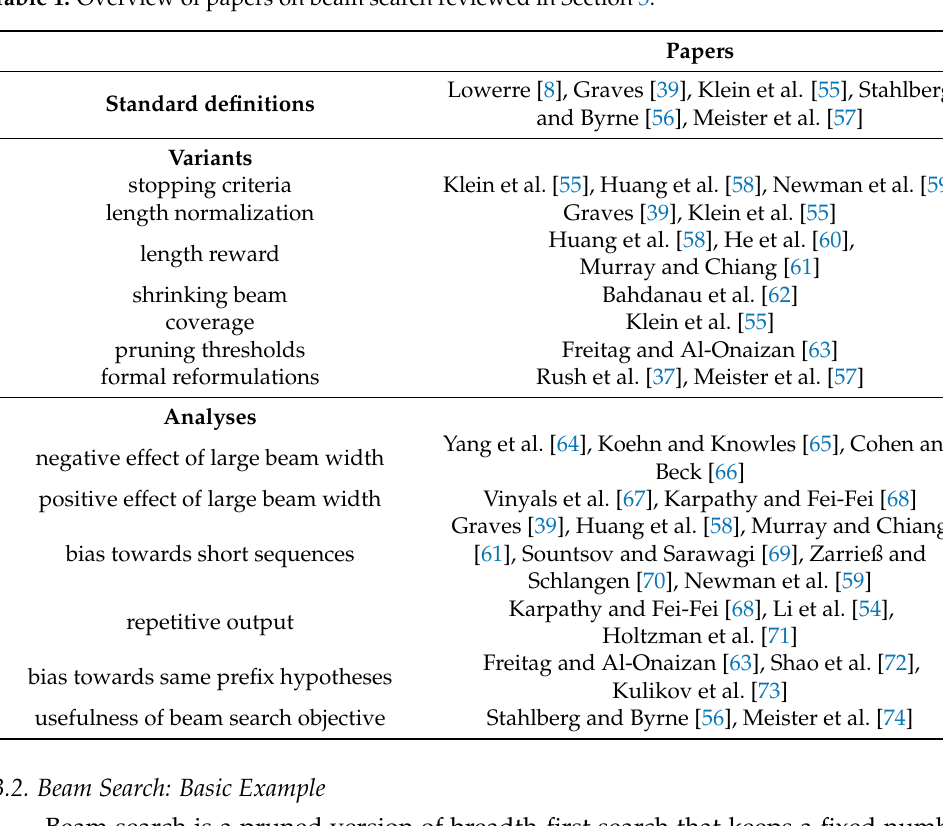
Table 1. Overview of papers on beam search reviewed in Section